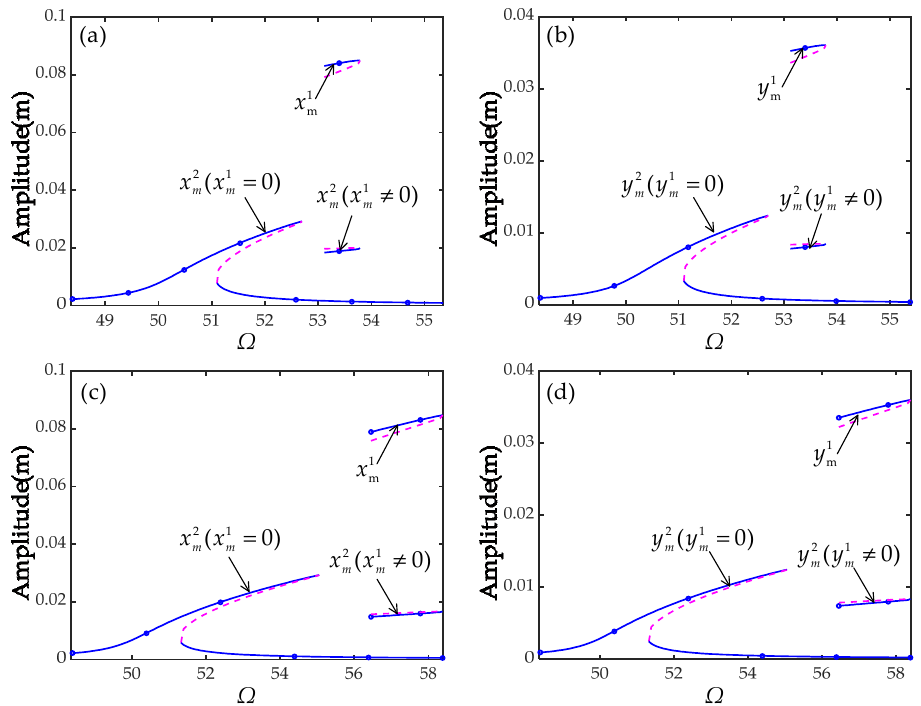
Figure 10. Frequency response curves for the second mode at Ω = ω 2 + εσ 2 , σ 1 = 0.01, F = 0.8, ( a , b ) k N = 1.2 × 10 4 N · m/rad 3 ; ( c , d ) k N = 2.4 × 10 4 N · m/rad 3 .